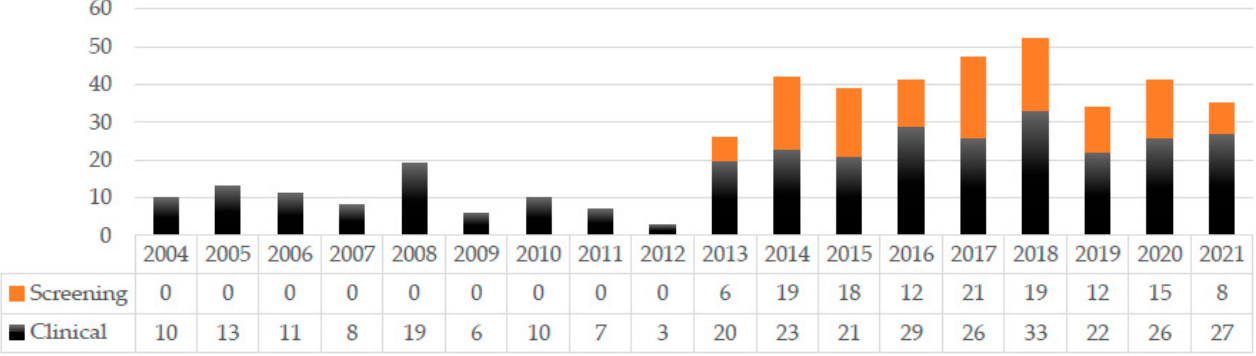
Figure 1. Number of Achromobacter isolates detected in the clinical and screening specimens each